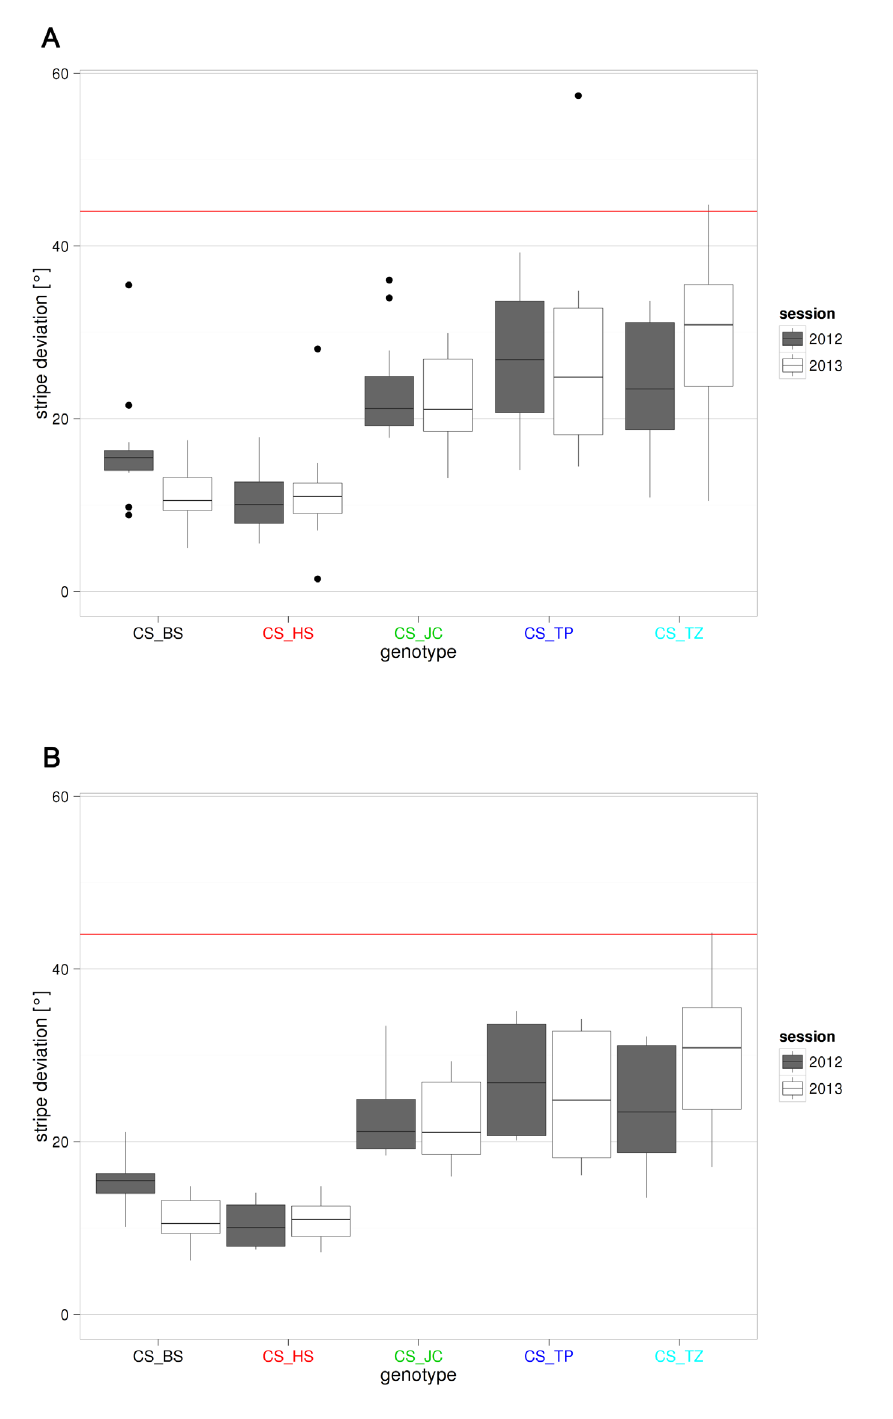
Figure 3. The different sub-strains show a large spectrum of values for the stripe deviation parameter. For every movement of the fly, the angle between its direction and the direction toward the stripes was calculated. The median of these angles was calculated for each fly, representing a quantification of stripe fixation by the fly. The value of each sub-strain in each session is depicted in boxplots: for each group, we represent the median, 25–75% quantiles and the total spread of the values (excluding outliers) as line, box and whiskers, respectively. The version of this figure on the F1000Research website is interactive; readers can define the type of whiskers displayed as either Tukey whiskers (1.5 x IQR from 1 st /3 rd quartile; A ) or the 10 th –90 th percentiles ( B ). The text color code used for the genotypes is analogous to that used in Figure 2. The red horizontal line corresponds to the median value for random walks: 44°. Sample size is 11–12 for each boxplot. No statistical analysis was